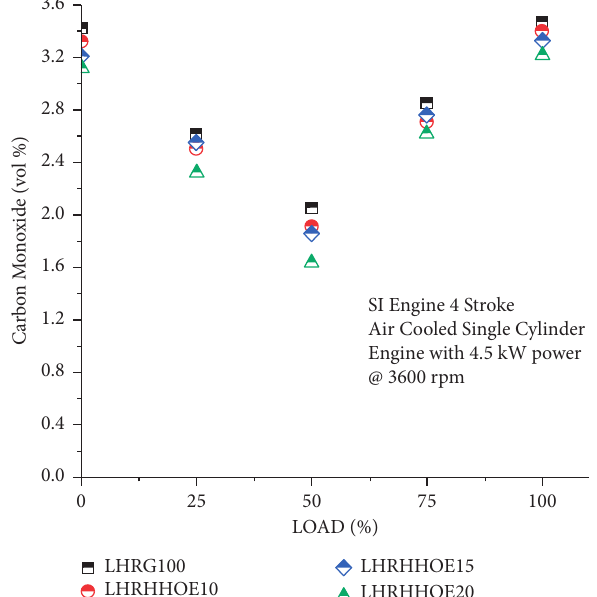
Figure 4: Study on carbon monoxide emission on nanocoated ethanol-gasoline engine.